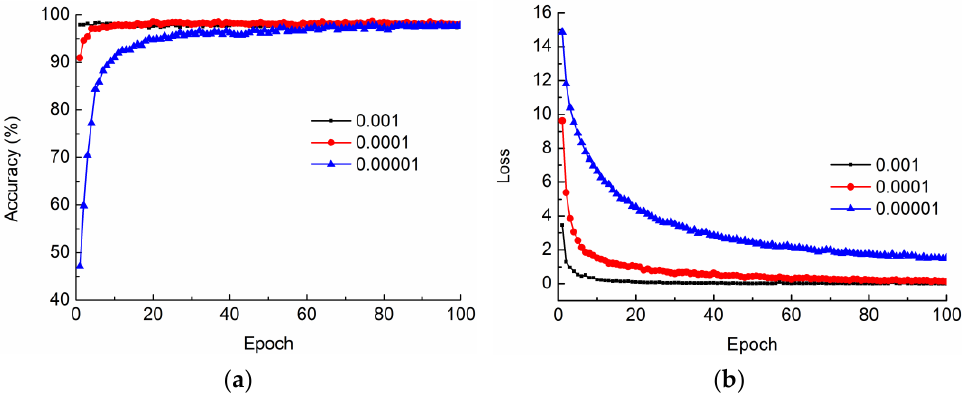
Figure 5. Validation results of different learning rates using ASGD: ( a ) Accuracy; ( b ) loss value.